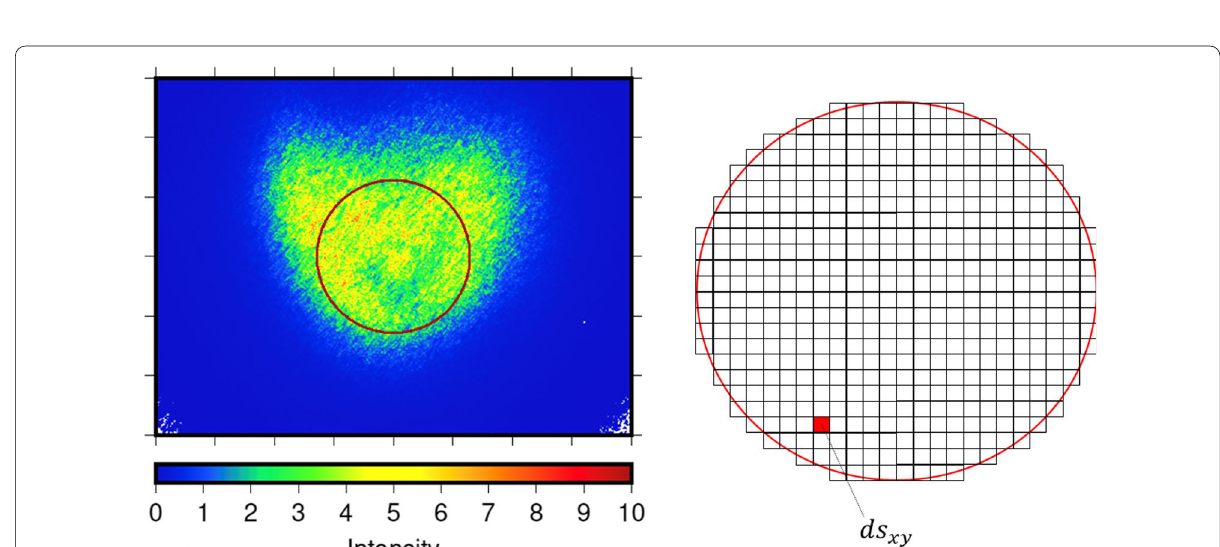
Fig. 1 Normalized transmitted laser beam pattern. The red circle on the left figure represents the field of view (FOV) of the FAR telescope. The right figure shows an image of numerical integration of the Ryugu surface within the FOV. See Eq. (5) for ds